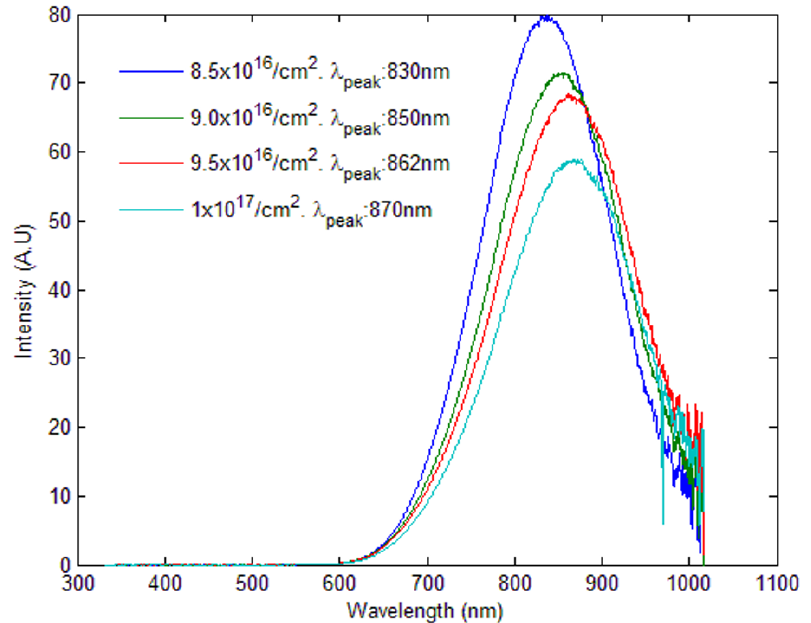
Figure 3. Photoluminescence spectra from Si quantum dots in SiO 2 /Si (001) produced by 90 keV Si + ion implantation. Si implantation doses are shown [32]. The maximum wavelengths ( λ peak , nm) of light emission are provided for each spectrum.